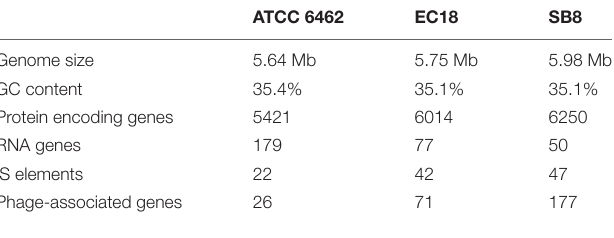
TABLE 1 | A comparison of the genomic features of Bacillus mycoides strains ATCC 6462, EC18, and SB8.